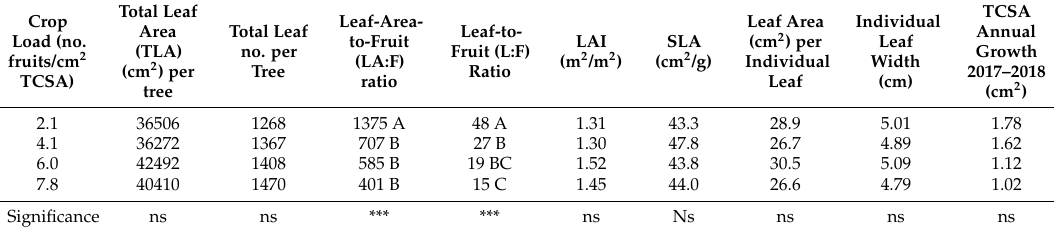
Table 4. The effects of crop load on total leaf area (TLA) (cm 2 ) per tree, total leaf number/tree, leaf-area (cm 2 )-to-fruit ratio (LA:F), leaf-number-to-fruit ratio (L:F), leaf area index (LAI) (m 2 /m 2 ), specific leaf area (SLA) (cm 2 /g), average leaf area (cm 2 ), and individual leaf width (cm) for “WA38” apple